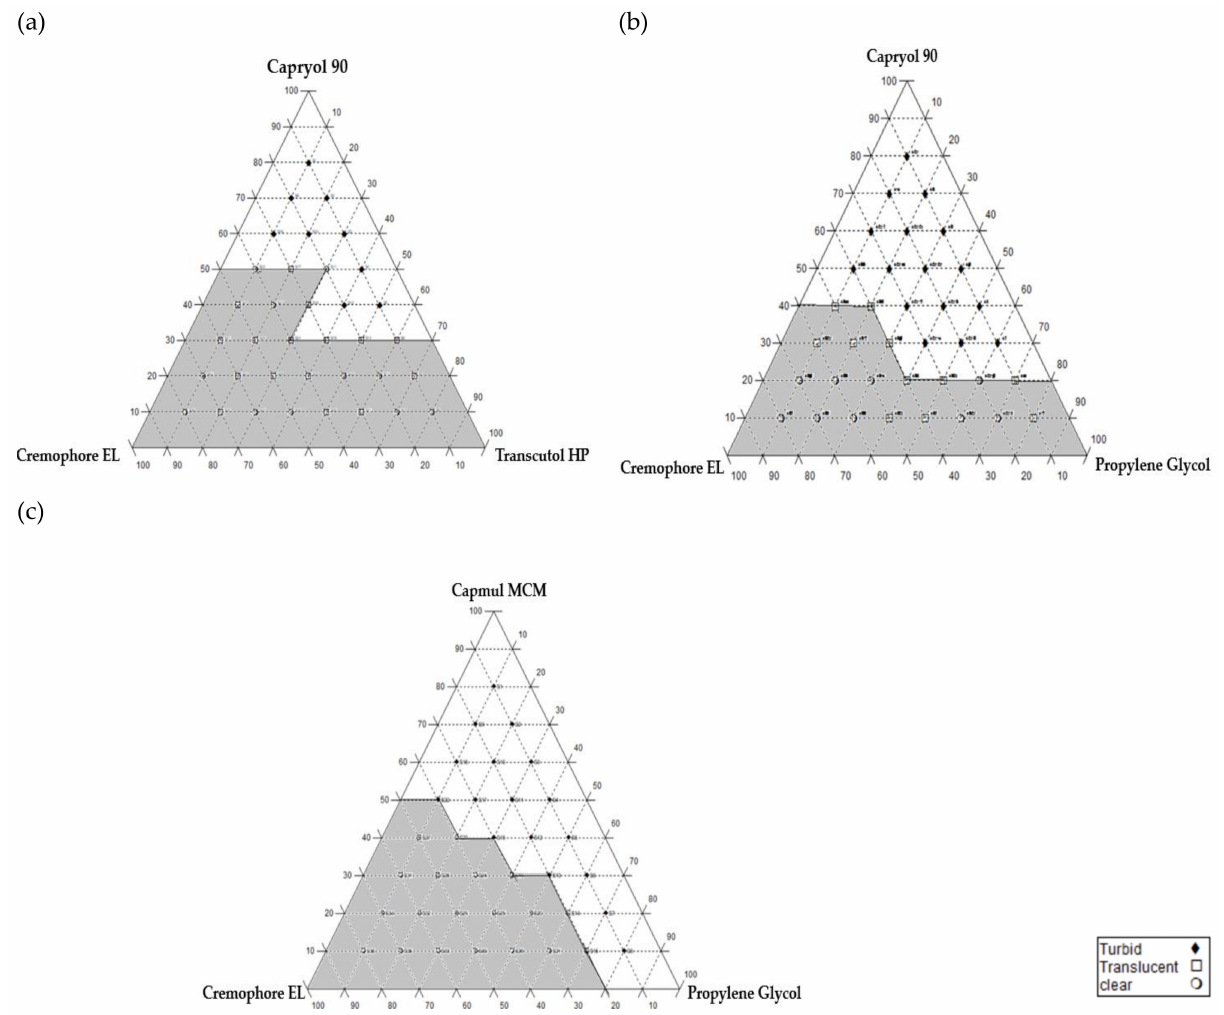
Figure 1. Pseudo-ternary phase diagrams for ( a ) system I (Capryol/Cremophor EL/Transcutol HP), ( b ) system II (Capryol/Cremophor EL/Propylene glycol) and ( c ) system III (Capmul MCM/Cremophor EL/Propylene